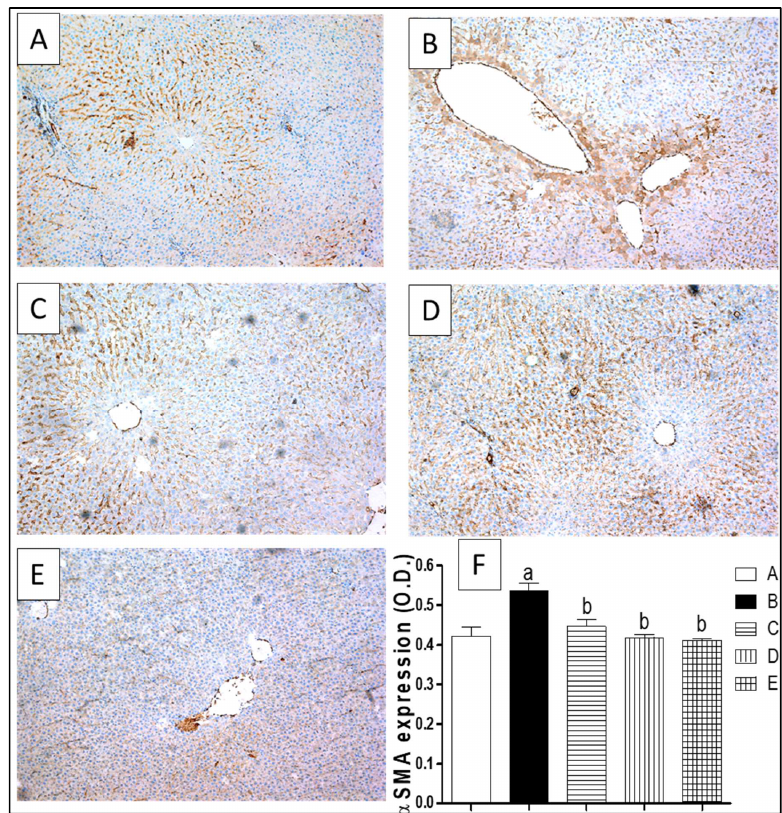
Figure 6. Expression of alpha smooth muscle actin (α-SMA) by immunohistochemical staining (×100). ( A ) Photomicrograph of liver section of control rats showing minimal immunostaining for α -SMA; ( B ) Photomicrograph of liver section of CCl 4 intoxicated rats showing extensive α -SMA expression of as shown by the intense brown staining; ( C ) Photomicrograph of liver section of (CCl 4 /Silymarin) treated rats showing limited α -SMA expression; ( D ) Photomicrograph of liver section of rats concurrently treated with CCl 4 (1 mL/kg) twice a week and ETN (100 mg/kg) three